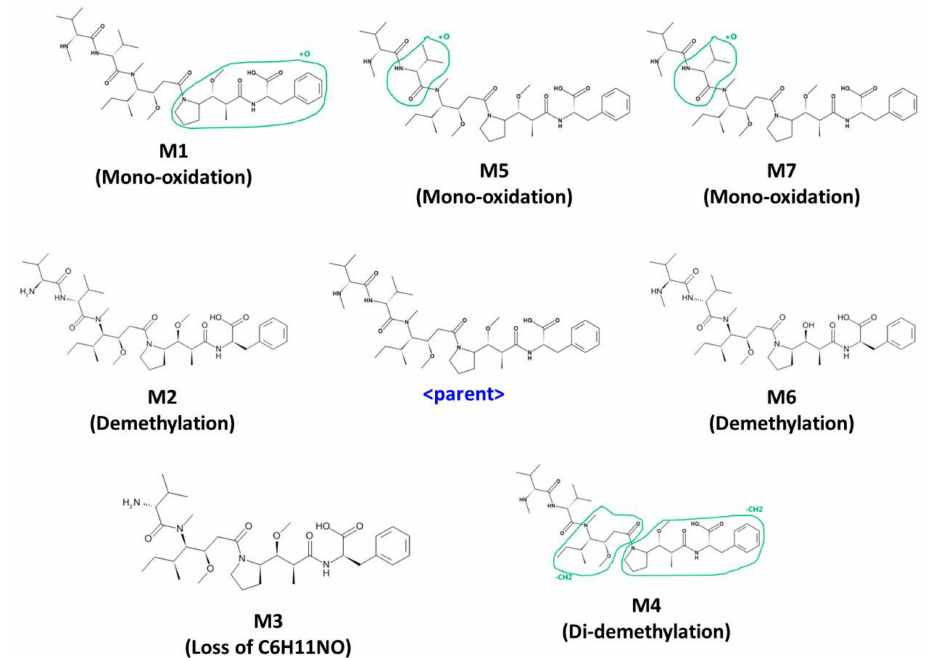
Figure 6. Metabolic pathway of MMAF (monomethyl auristatin F); Mono-oxidation, Demethylation, Di-demethylation, Loss of